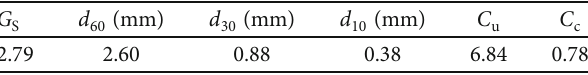
Figure 1: CKC automatic triaxial test system. Table 1: Physical properties of calcareous sand.